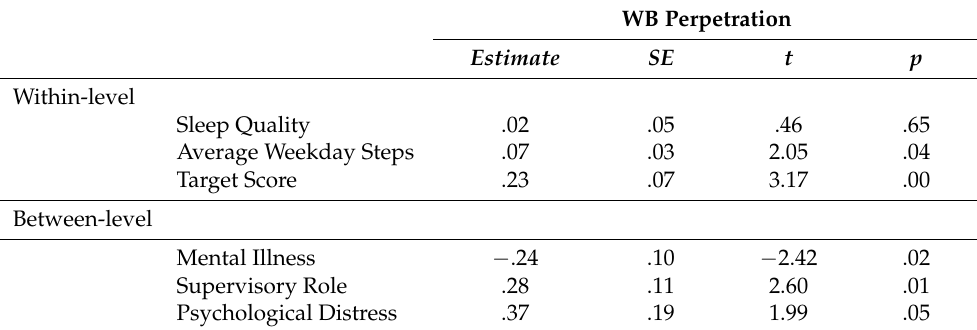
Table 3. Multilevel associations between predictors and WB perpetration (same